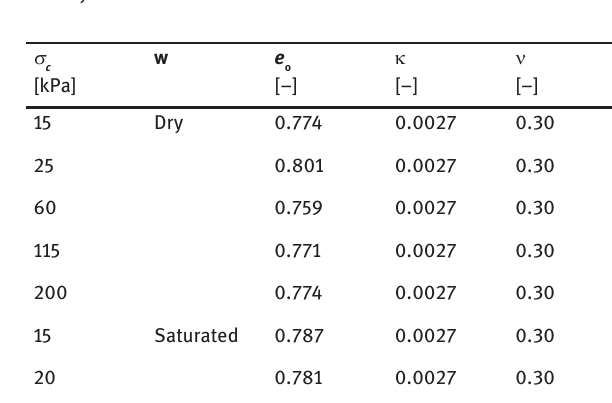
Table 1. Experimental conditions and elastic parameters of scaled railway ballast.